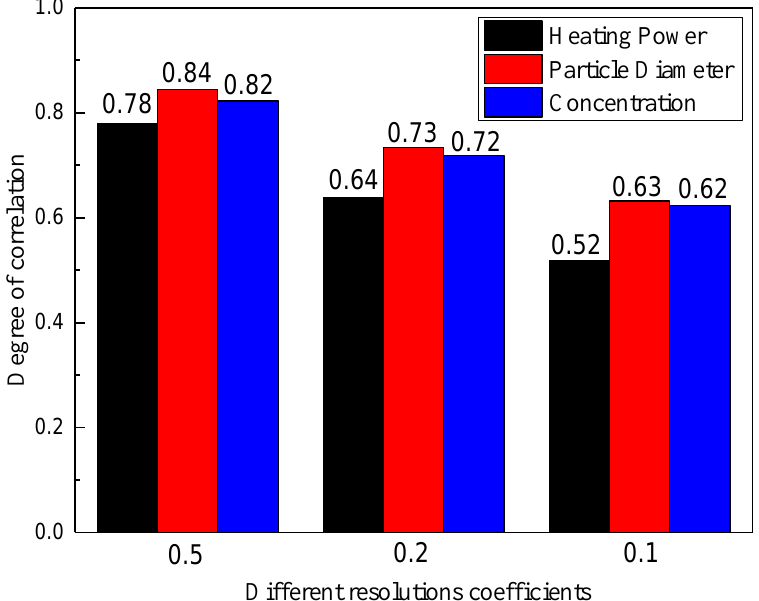
Figure 14. Correlation degree of particle deposition parameters.